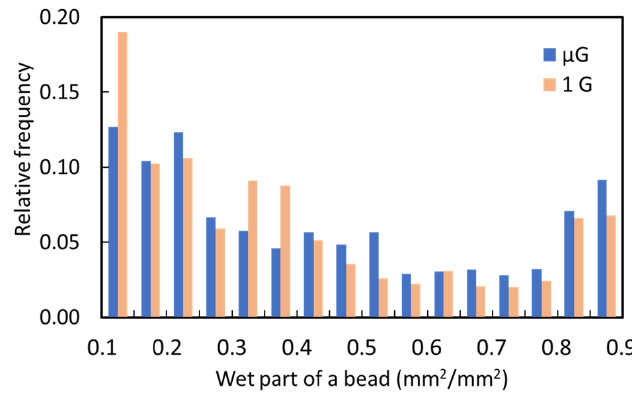
Figure 7. The relative frequency distribution of the wet part on each bead at every 0.001 s. The higher frequency implies the wetting front stopped there longer. Bimodal distributions were observed both under microgravity and under 1 G.